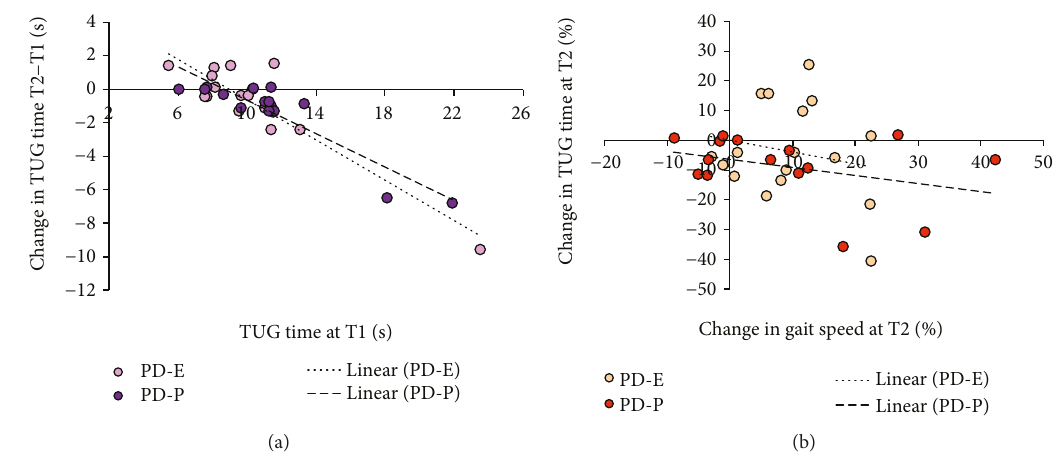
Figure 7: (a) The scatterplot shows the changes in TUG time (T2 – T1) plotted against the TUG time at T1 for each patient of both groups. For most patients, TUG time at T1 was close to the normal values of age-matched healthy subjects. The decrease in time was limited (or absent) in most cases, except for three patients, who improved much their initial performance. (b) Percent changes in TUG time after rehabilitation were not related to the percent improvement of gait speed assessed by baropodometry.